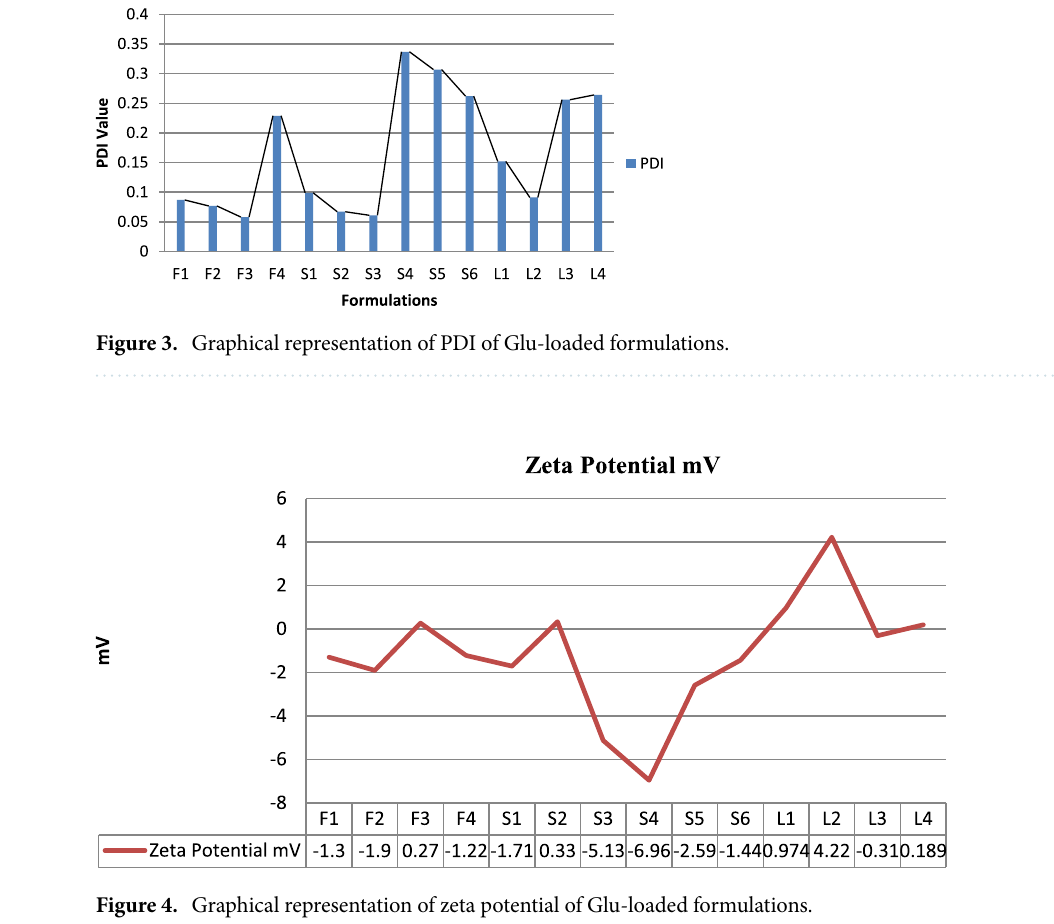
Figure 4. Graphical representation of zeta potential of Glu-loaded